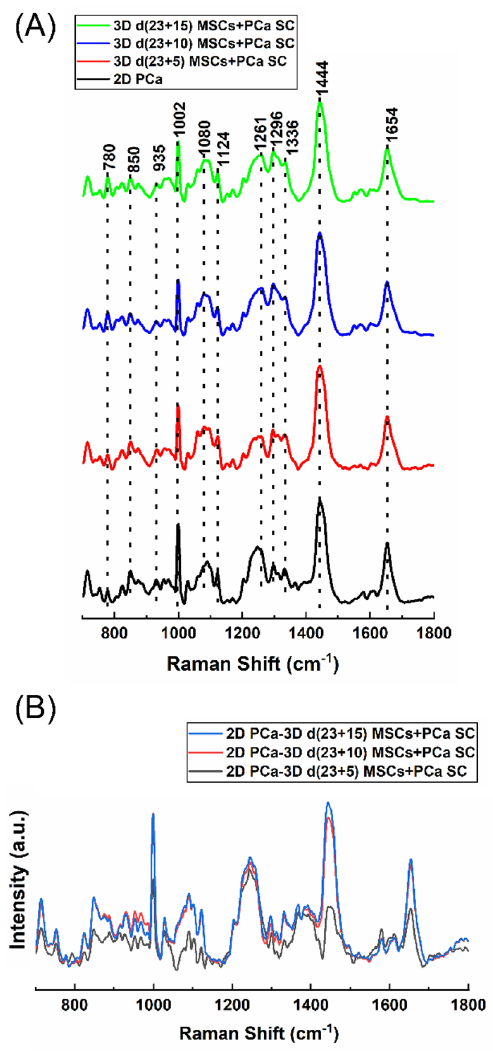
Figure 1. Raman spectra of prostate cancer cells. ( A ) Averages of 20 spectra from 4 samples (2D PCa and 3D MSCs + PCa SCs d(X + Y), where X = 23 days of MSCs culture and Y = 5, 10, and 15 days of cancer cell culture after 23 days of MSCs culture) are shown in bold and overlaid on representative examples of spectra for each sample. Spectra are color-grouped according to culture type and duration of culture. ( B ) The corresponding difference spectra were calculated from the averaged Raman spectra between 2D culture and three different 3D